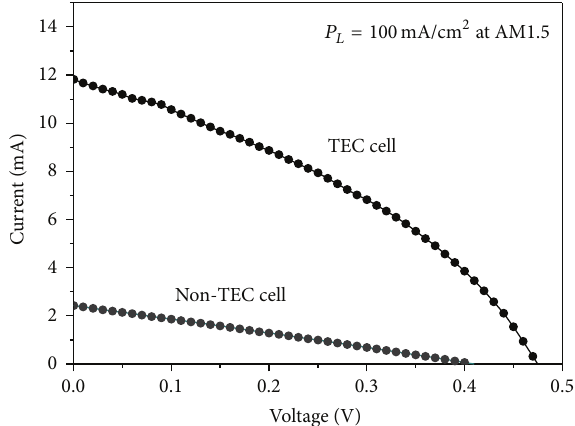
Figure 6: Current-voltage characteristics of the NPS/poly-Si cells with and without a trenched-electrode-contact (TEC) structure, measured by a solar simulator under 𝑃 𝐿 = 100 mA/cm 2 at